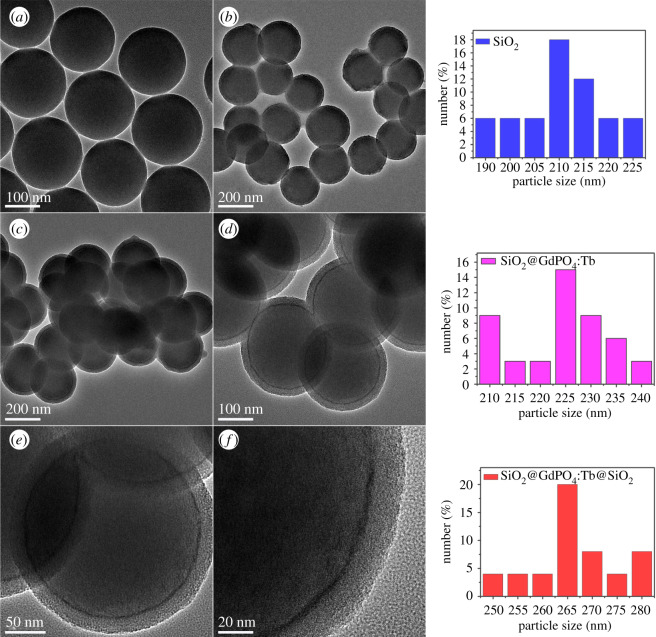
TEM images of the products (a) SiO2, (b) SiO2@GdPO4:Tb, (c–f) SiO2@GdPO4:Tb@SiO2, and corresponding size distribution images.